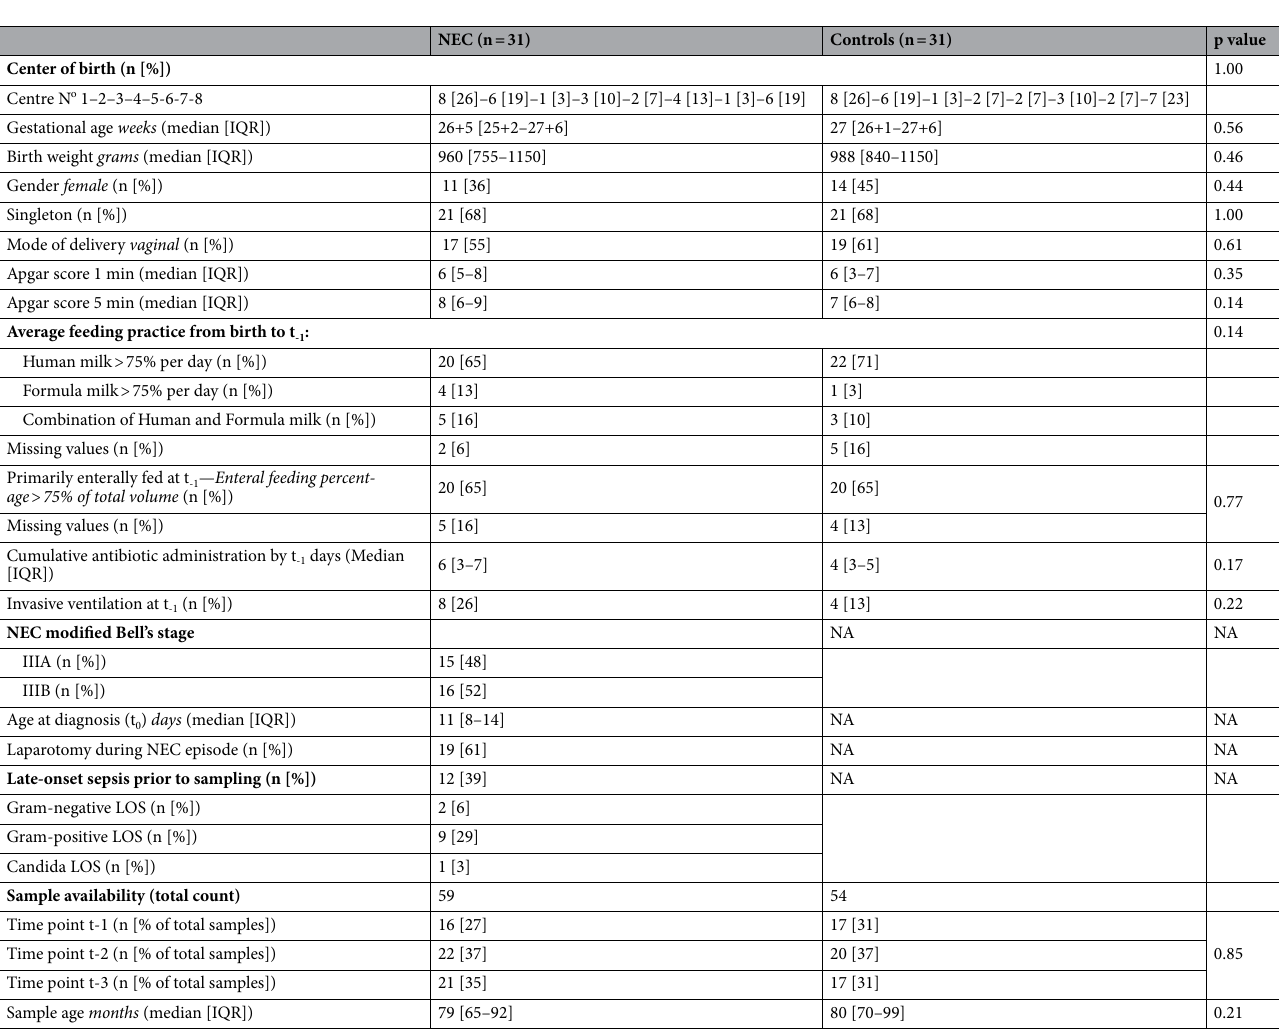
Table 1. Baseline demographic, clinical and sampling characteristics. IQR interquartile range , n number of infants, LOS late-onset sepsis, NEC necrotizing enterocolitis, t 0 day of diagnosis, t -1 1 day prior diagnosis, t -2 2 days prior diagnosis, t -3 3 days prior diagnosis